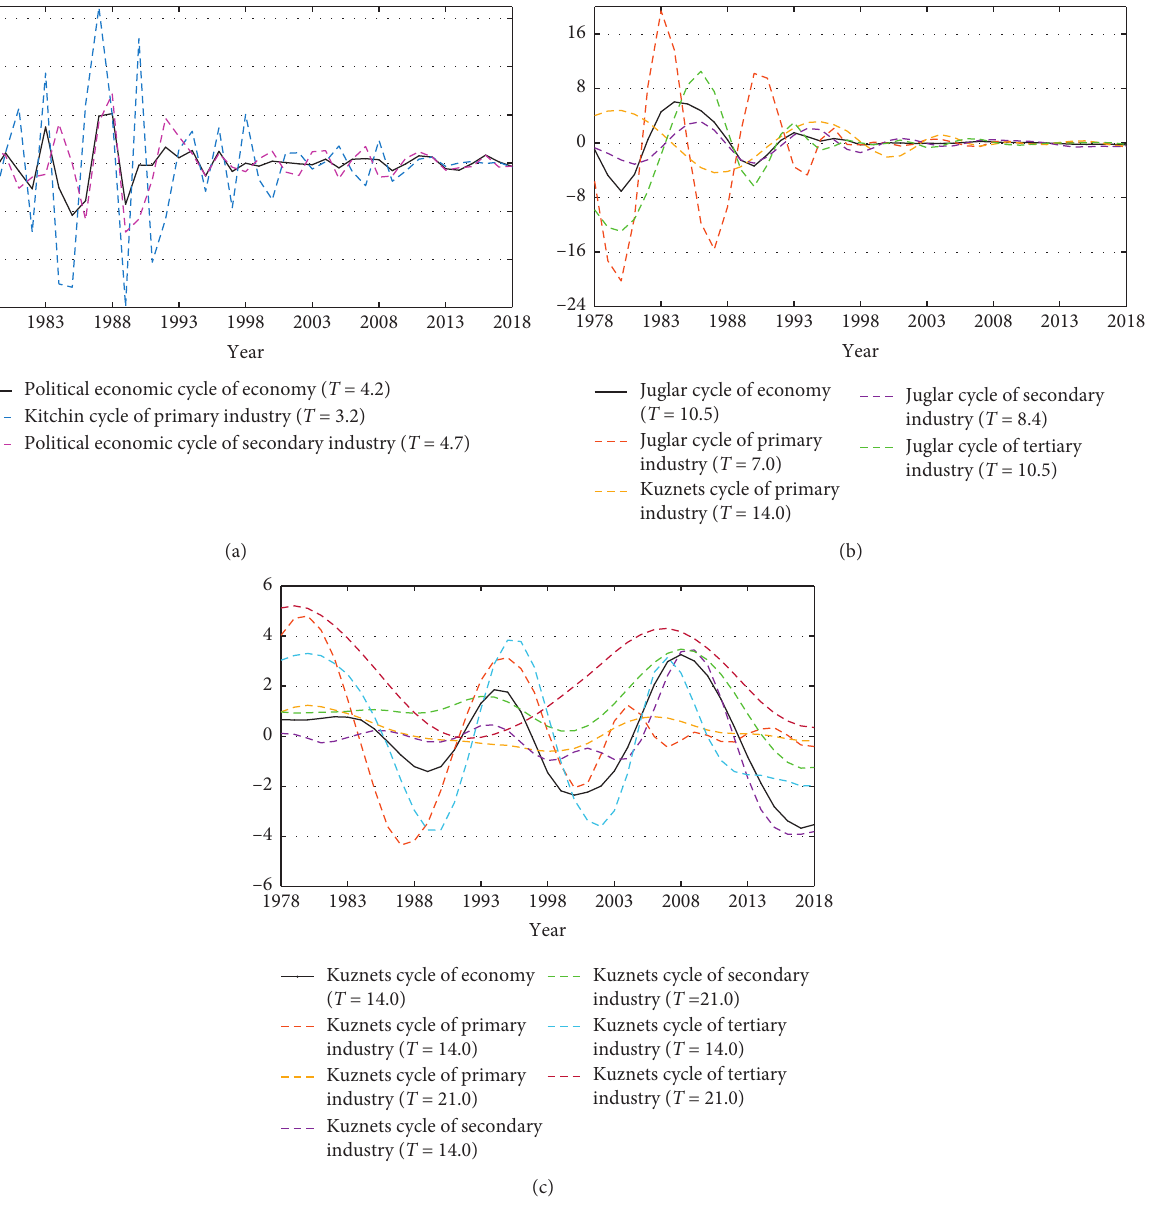
Figure 4: Line charts of the economic and industrial components in Jilin Province. (a) Political and economic cycle of economy and related industry components. (b) Juglar cycle of economy and related industry components. (c) Kuznets cycle of economy and related industry